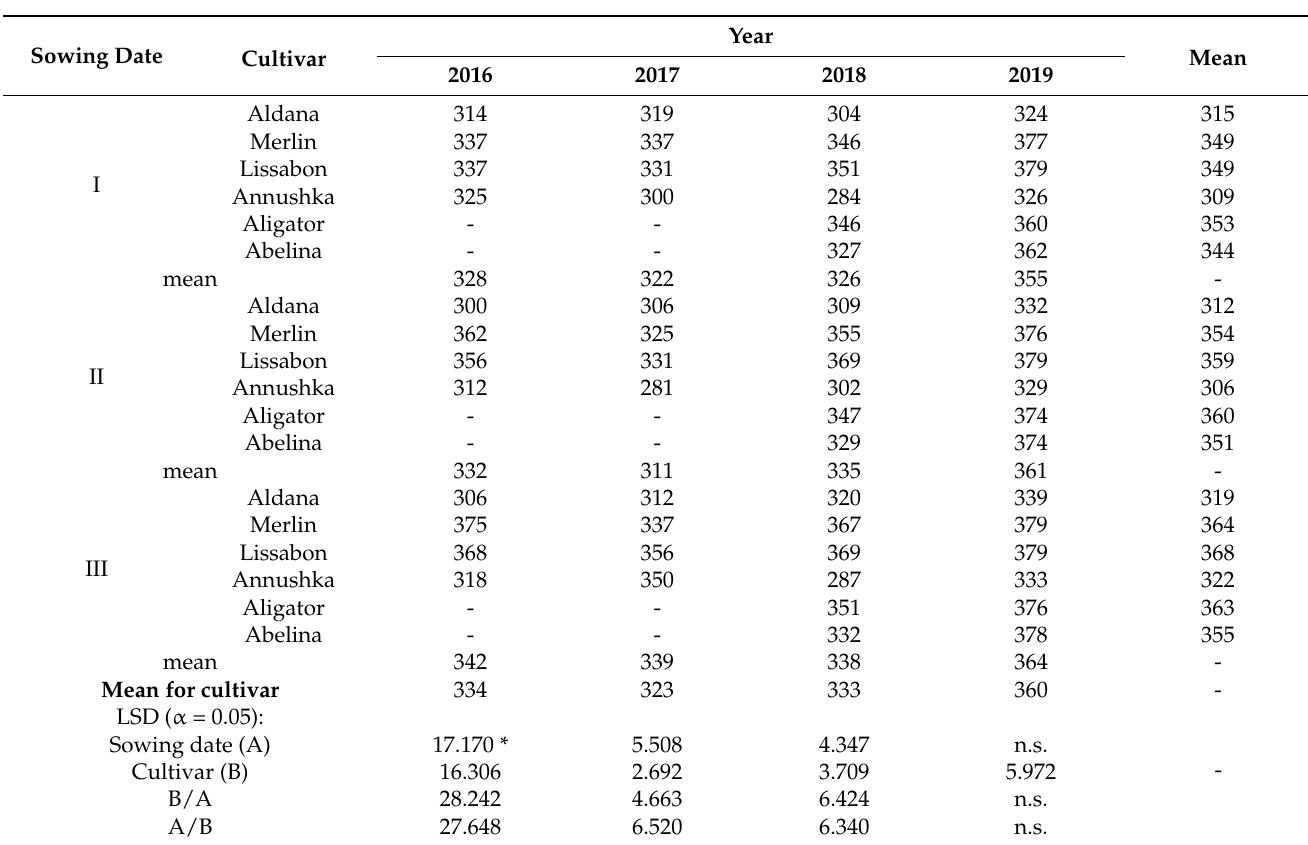
Table 5. Crude protein content in soybean seeds depending on cultivar and sowing date (g kg − 1